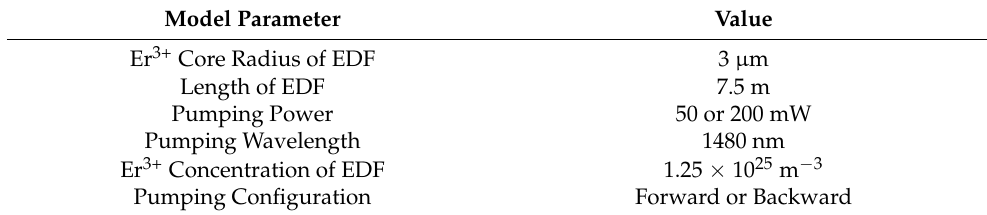
Table 4. Parameters of EDFA in ROA 3.